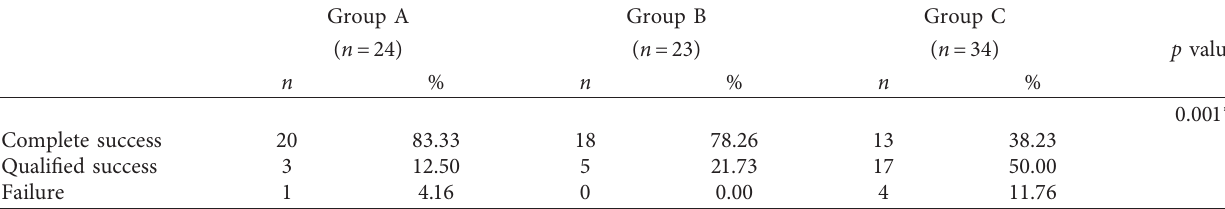
Table 3: Results of primary outcome in IOP control.